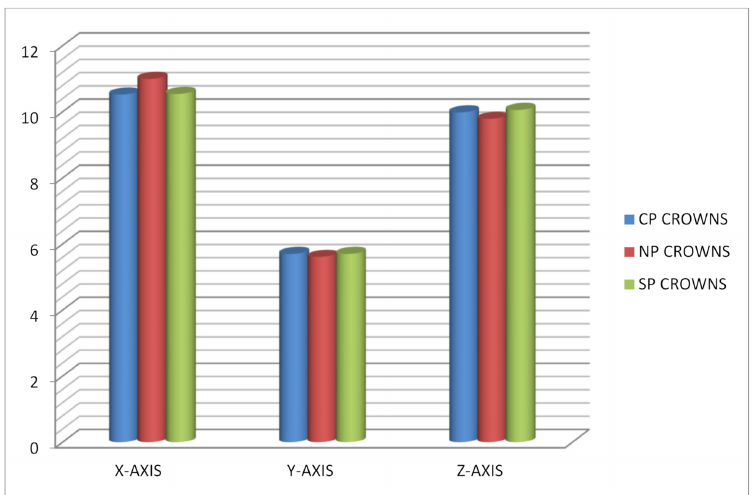
Figure 3. Shows mean fracture resistance observed with different types of posterior crowns at different